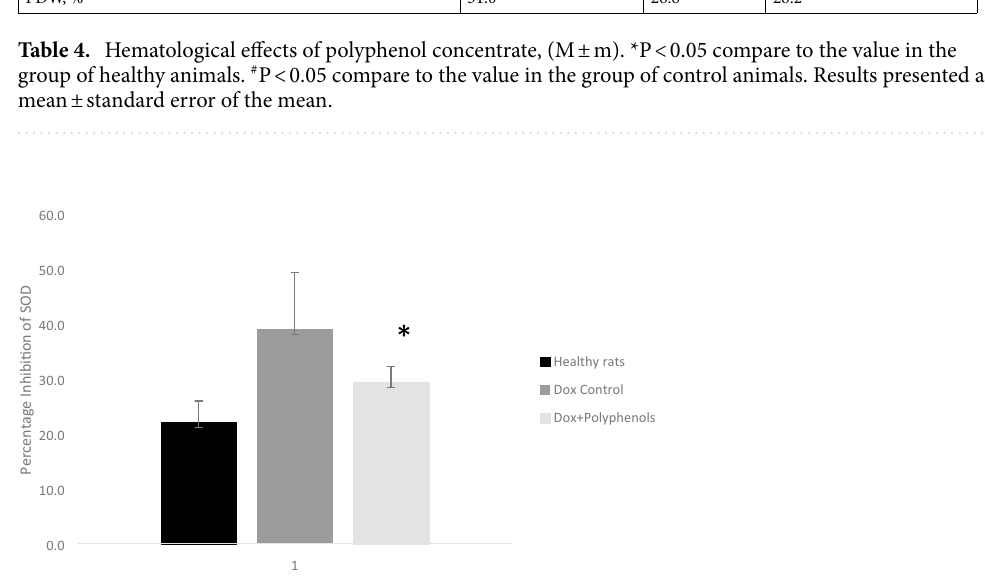
Figure 1. Percentage inhibition of SOD. The graph shows the inhibition of SOD activity as measured by the colorimetric absorbance method. The decrease in SOD activity is proportional to the amount of absorbance at 440 nm. Results presented are mean ± standard error of the mean of 5 independent experiments from 6 different animals per each treatment group. * Represents significance difference (α <